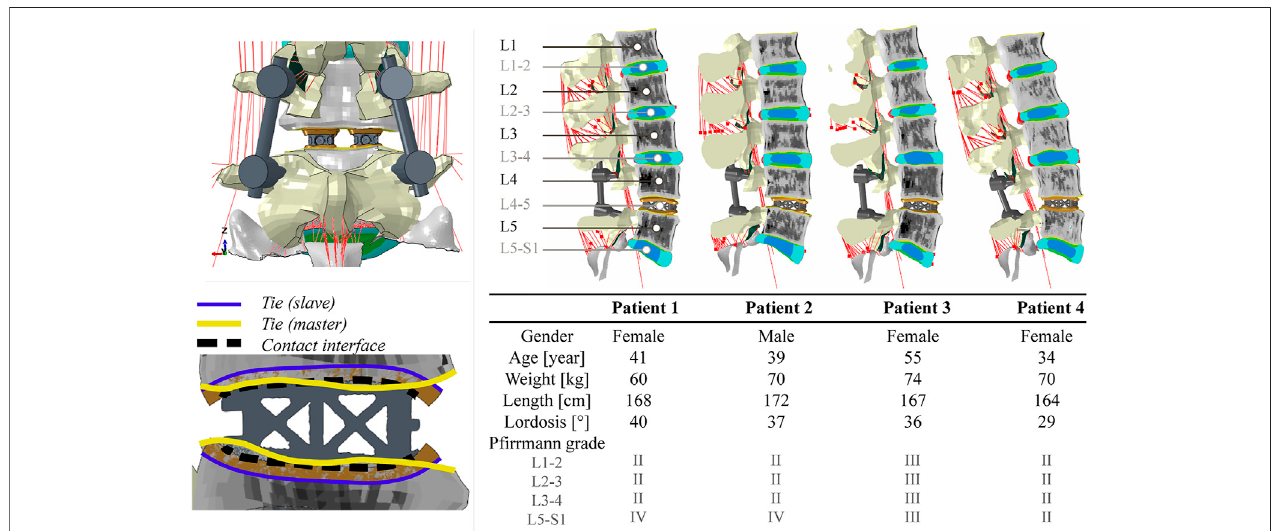
FIGURE 1 | Top left: posterior view of segment L4-5 following PLIF surgery. A complete laminectomy was performed and two interbody cages were inserted. Bottom left: graphical overview of the interaction properties prescribed for cage vertebra interaction. The outer surface of the contact layer (purple) is rigidly tied to the associated bony endplate surface (yellow). Hard normal contact and a coef fi cient of friction of 0.20 were used to describe the contact between the cage and the inner surfaceofthecontactlayer(dashed blackline).Right:amidsagittal cutofeachofthefour operated patient-speci fi cmodels withcorresponding demographic data. The different colors in the models represent different material